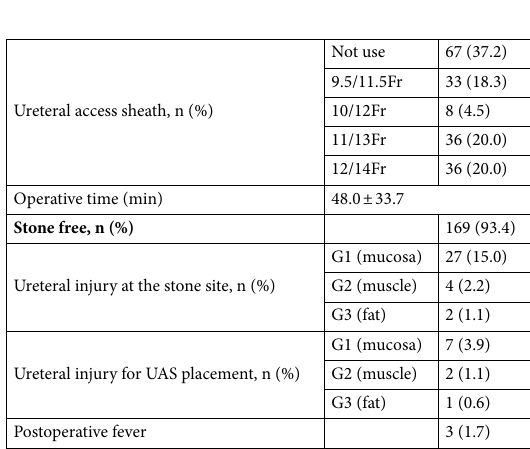
Table 2. Surgical outcomes (n = 180). UAS ureteral access